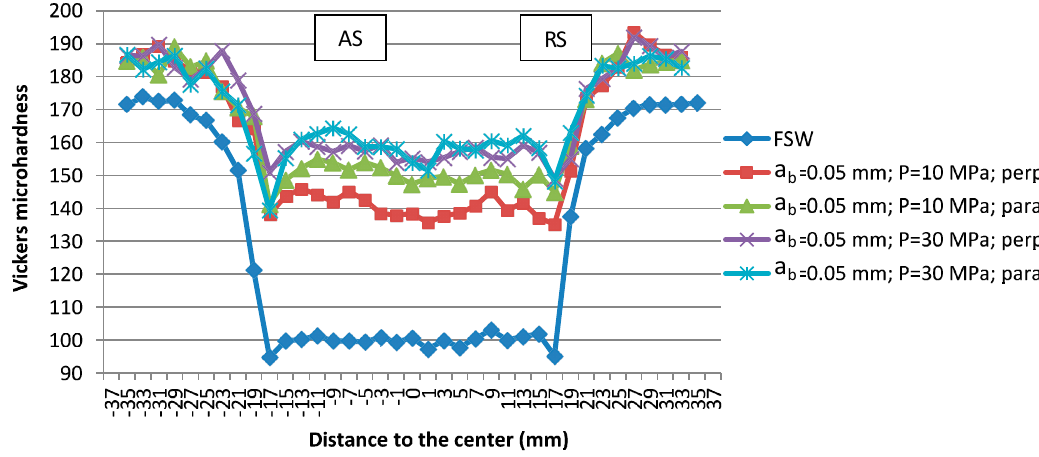
Figure 12. Effect of burnishing direction on microhardness values for a b = 0.05 mm.